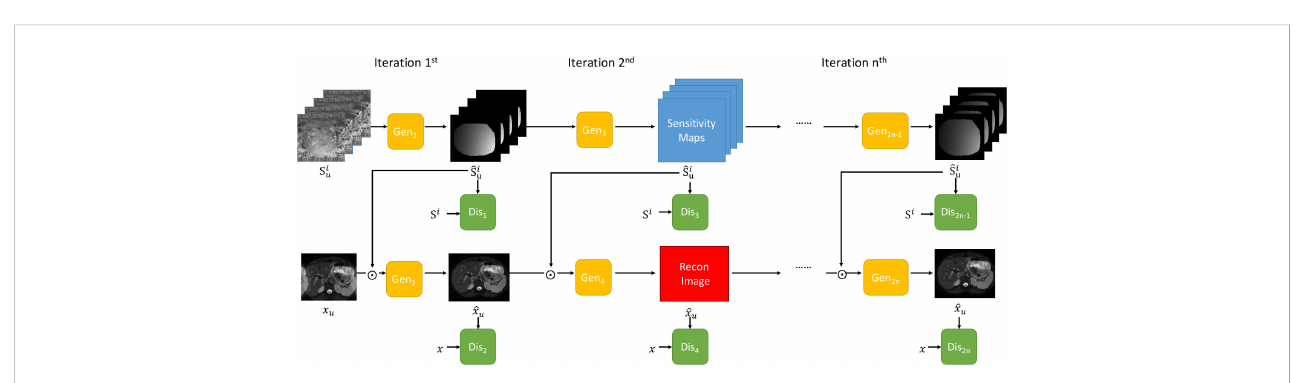
FIGURE 1 The overall framework of the proposed iterative multi-channel GAN. Gen represents the generator and Dis indicates the discriminator. Three iterations are